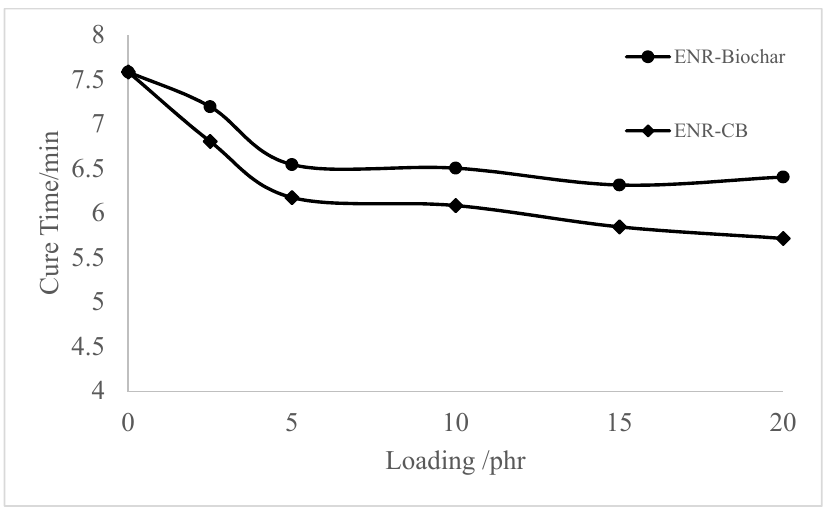
Figure 2. Cure time (tc90) of the ENR, ENR ‐ Biochar and ENR ‐ CB.